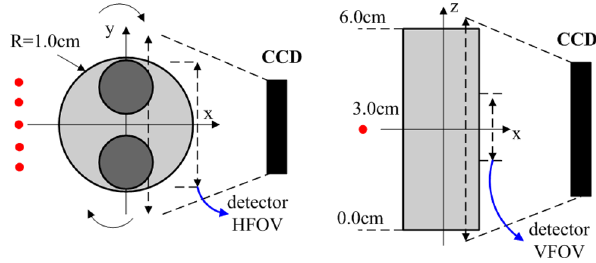
Figure 3. Simulation experiment sketch. A full-angle CCD camera– based imaging system configuration was used for the data simulation. The imaged object was a cylinder phantom with two embedded cylinder heterogeneities (different absorption coefficients). For each projection, five different excitation sources were scanned (red dots), and the detectors, which corresponded to selected detection points on the image plane, were within 1.8 cm of the detector horizontal FOV (HFOV) and 2.2 cm of the detector vertical FOV (VFOV) with a detector spacing of 0.2 cm.